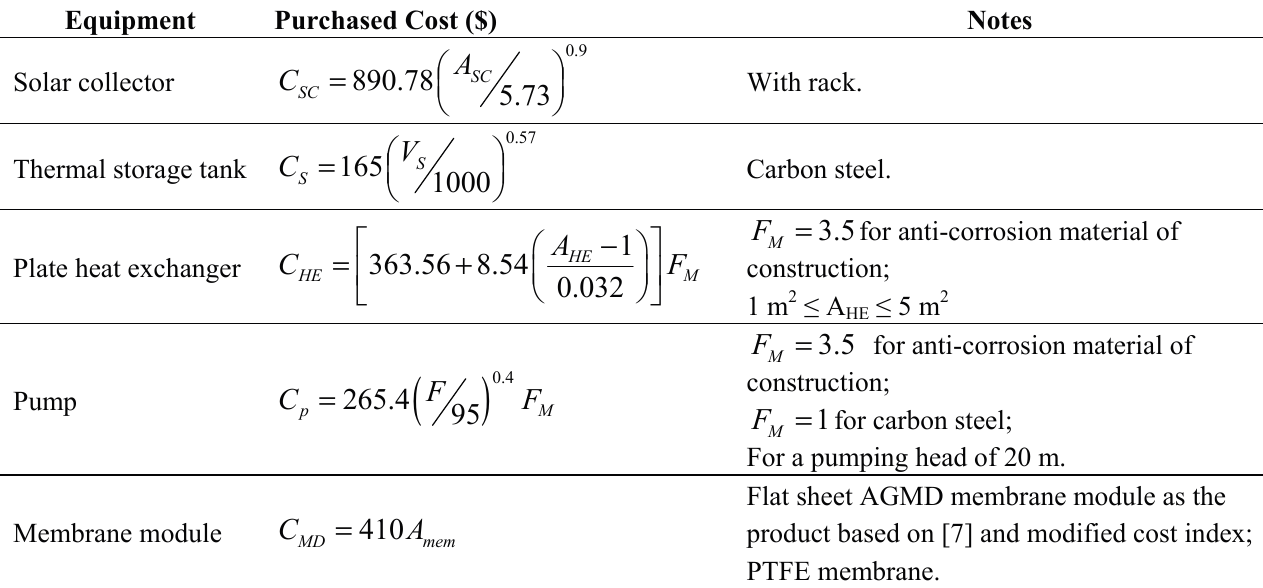
Table 2. Cost functions for